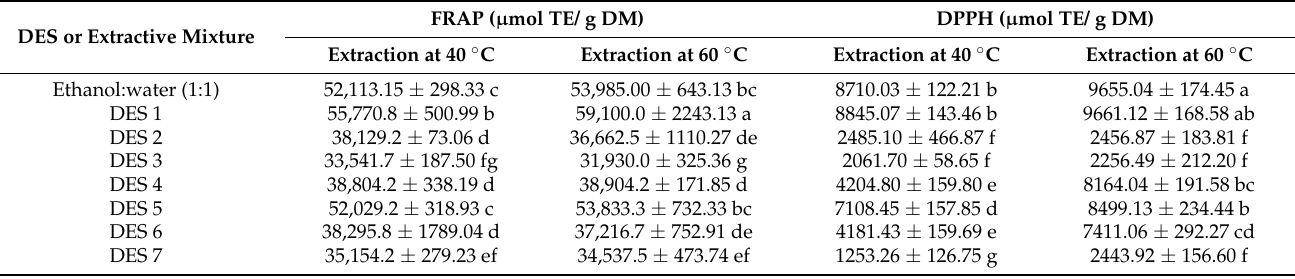
Table 4. Results of antioxidant capacity for group 1 extractions from CPWP.